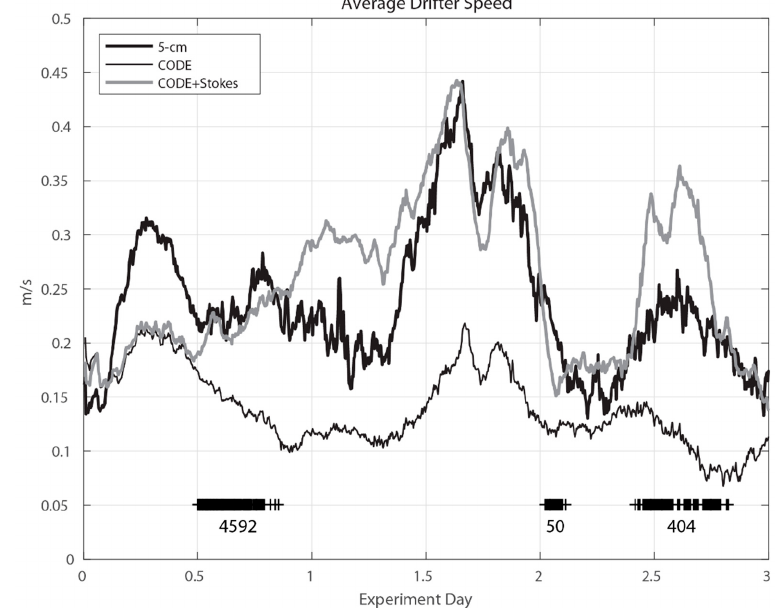
Figure 10. Time series of mean speed of all 5-cm drifters (thick black line) and CODE-style drifters (thin black line) for the first three days of the field experiment. The gray line is the mean of the magnitude of CODE drifter velocity plus the surface Stokes drift velocity. Black plus symbols near the bottom indicate times of co-located drifter velocity observations plotted in Figure 9, and the number of each co-located pair of observations in each cluster is